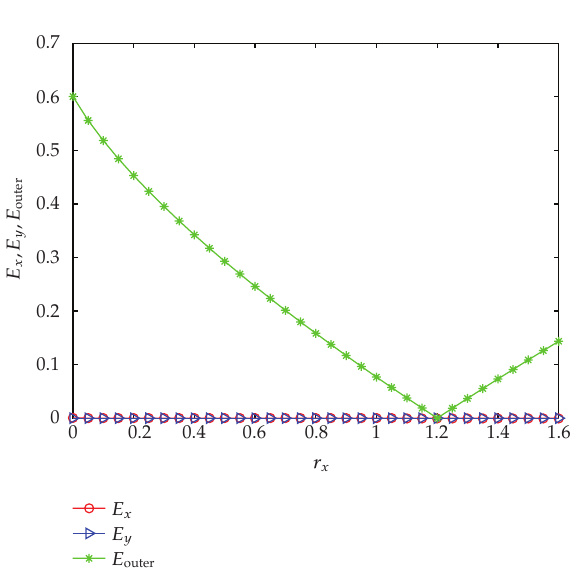
Figure 7: The curves of E x ,E y , and E outer versus r x for r y (cid:7) 0 . 2. The other parameters are τ x (cid:7) 0 . 3, τ y (cid:7) 0 . 5, ρ 1 (cid:7) − 0 . 3, and ρ 2 (cid:7) 0 . 6.